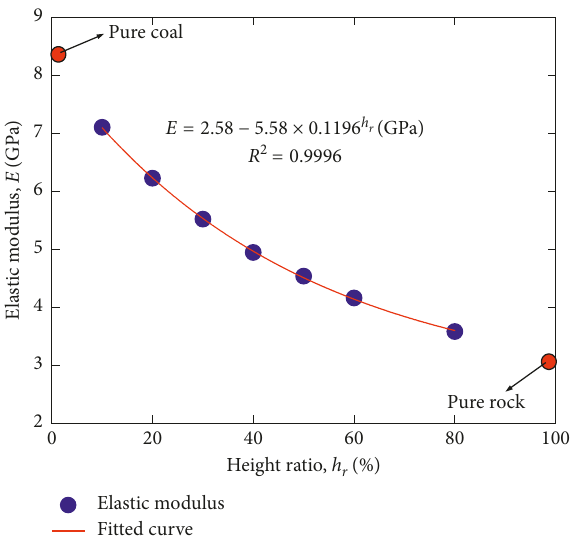
Figure 9: Relationship between height ratio and elastic modulus.